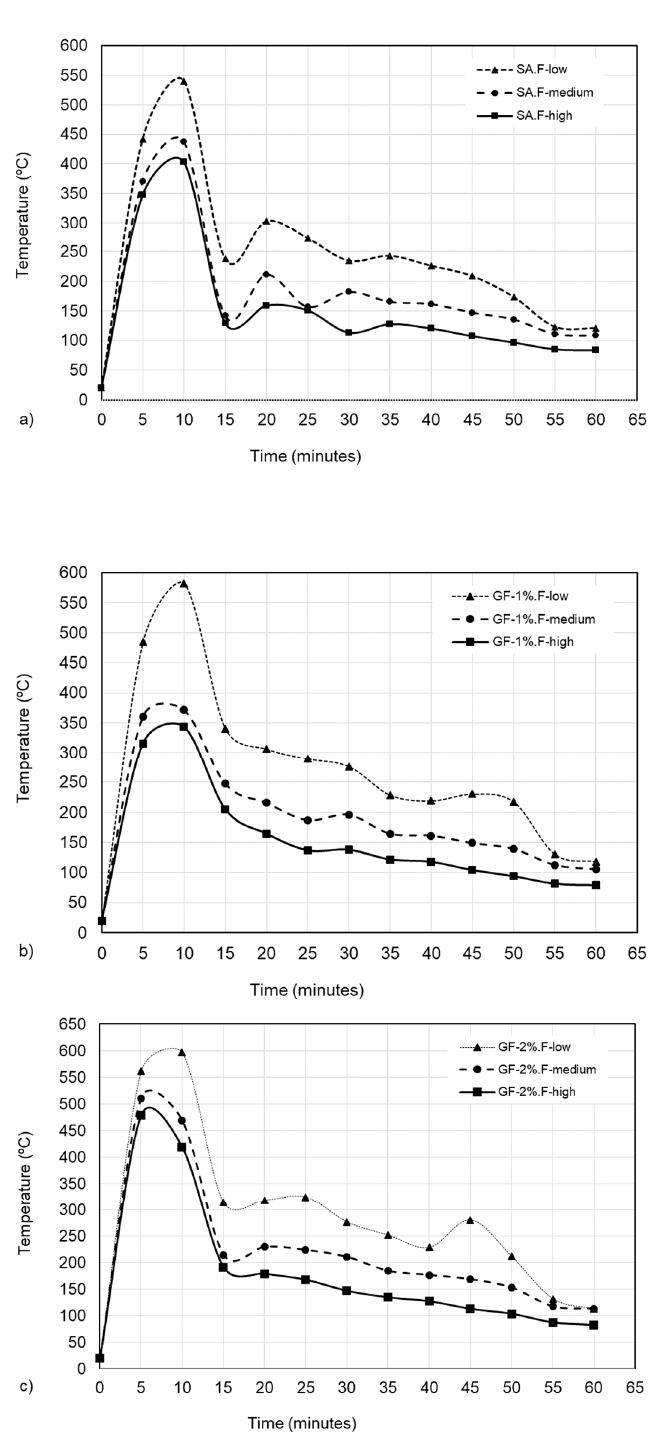
Figure 5. Evolution of temperature over time in test pieces without addition, with percentages of 1% and 2% of CNFs in their upper, middle and lower sections.